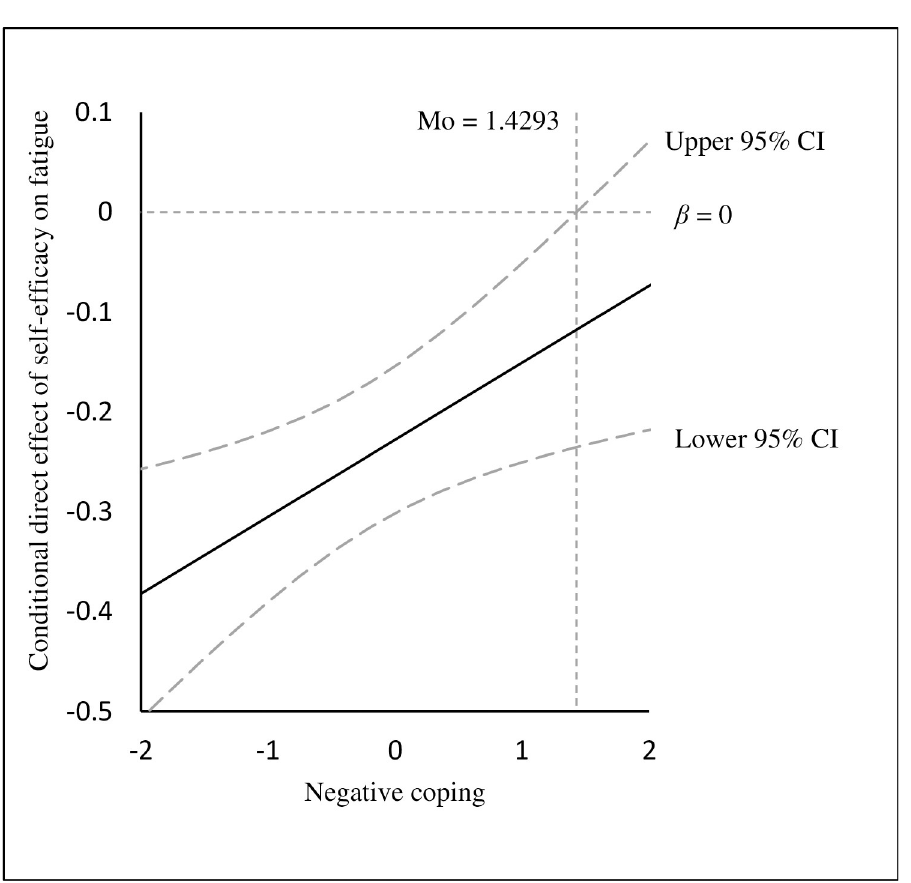
Fig 2. The conditional direct effect of self-efficacy on fatigue at the values of negative